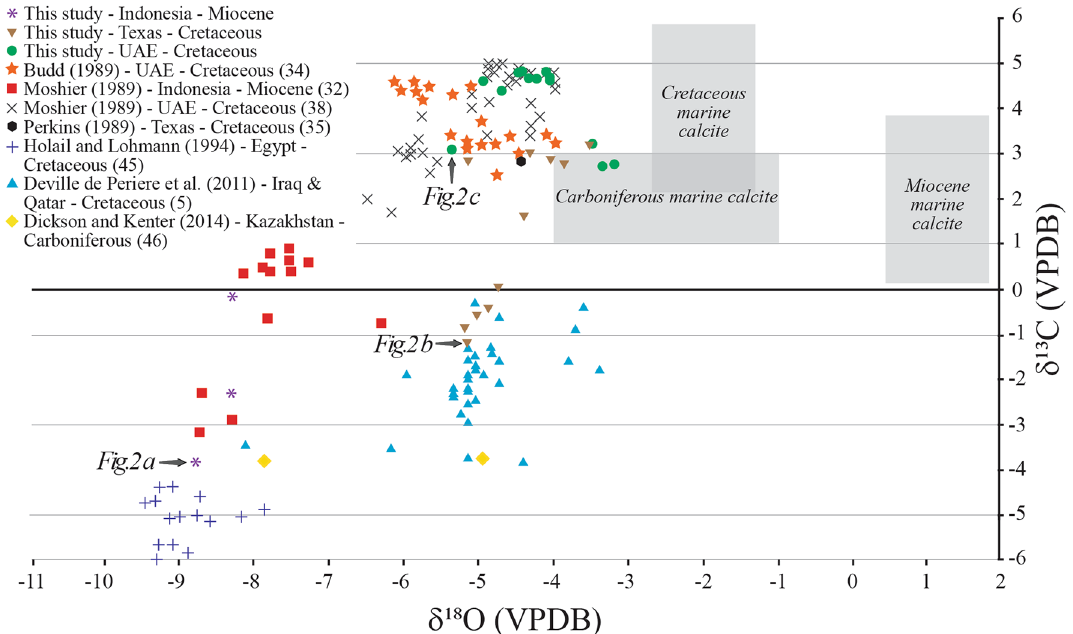
Figure 3. δ 13 C and δ 18 O from Phanerozoic limestones characterized by rhombic calcite microcrystals (Table 1). Gray boxes represent the estimated isotopic composition of marine calcite adopted from Ref. 10 . Gray arrows point to data from samples whose SEM images are shown in Fig.